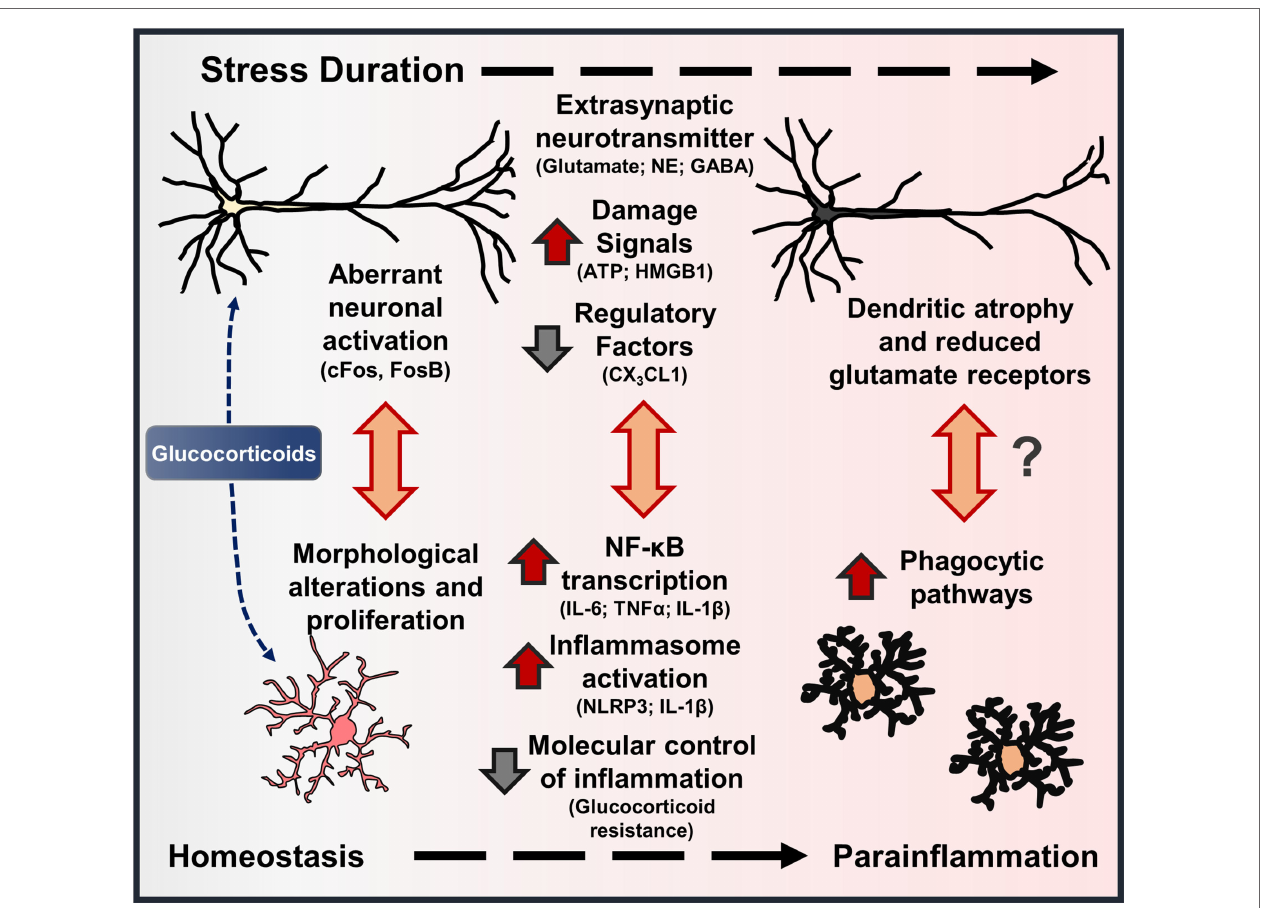
FiGURe 3 | Stress-induced neuronal dystrophy contributes to alterations in microglia function and parainflammation . Models of environmental and psychosocial stress activate characteristic neuroendocrine (i.e., glucocorticoids – GC) and neuroimmune pathways that contribute to neuroplasticity alterations underlying anxiety- and depressive-like behaviors. In this cascade, there are features that show stress-induced “neuroinflammation” resembles parainflammation. As brain-resident macrophages, microglia interact with proximal neurons, and disruptions in neuron–microglia interactions initiate morphological and functional changes in microglia. Repeated stress (i.e., prolonged elevations in glucocorticoids) leads to aberrant neuronal activation, extrasynaptic neurotransmitter levels, and release of neuron-derived damage signals. These signals further promote mild to moderate levels of neuroinflammatory transcription and inflammasome activation in microglia. With persistent or chronic stress, pyramidal neurons undergo dendritic atrophy and reduce glutamate receptors, which may be precipitated by cytokines released by proximal microglia or microglia-mediated synapse elimination. Collectively, these stress-induced neuronal responses and resultant molecular and cellular cascades resemble a state of